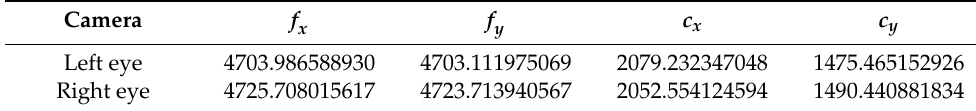
Table 2. Binocular camera internal parameters.